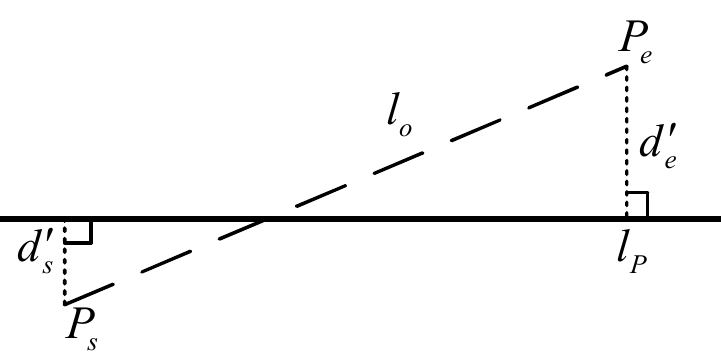
Figure 7. Reprojection error of the line feature.